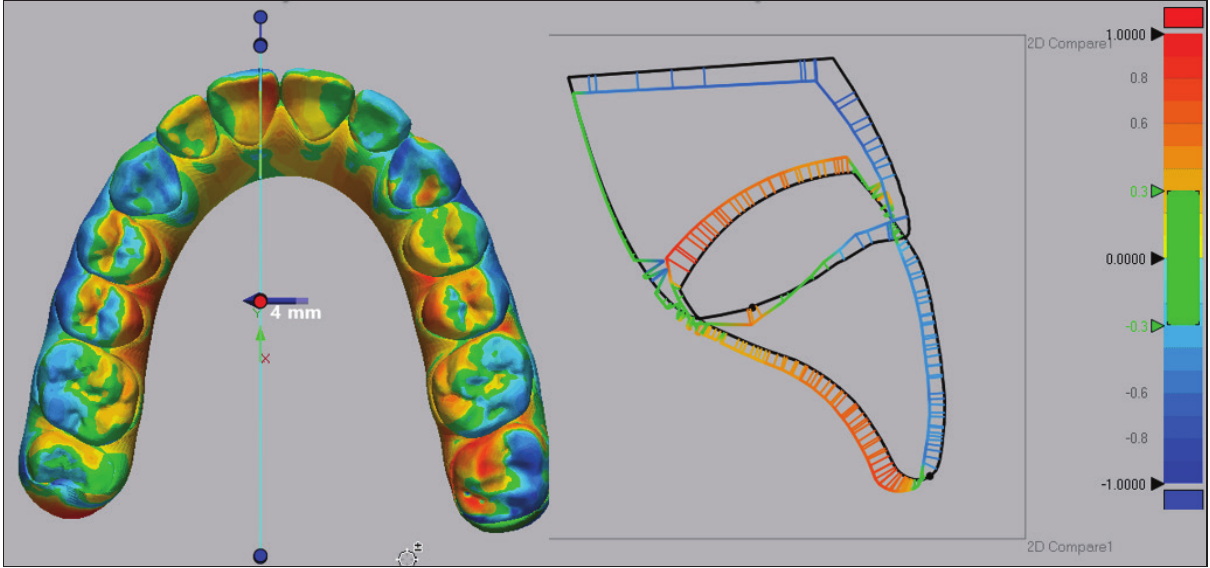
Figure 8. A 2D slice heat map generated in the X axis through the upper right central incisor. The reference model is in black, the measured model is coloured, depending on direction and amount of displacement. In this model the incisor crown is displaced more palatally and slightly more incisally than the prescribed position.